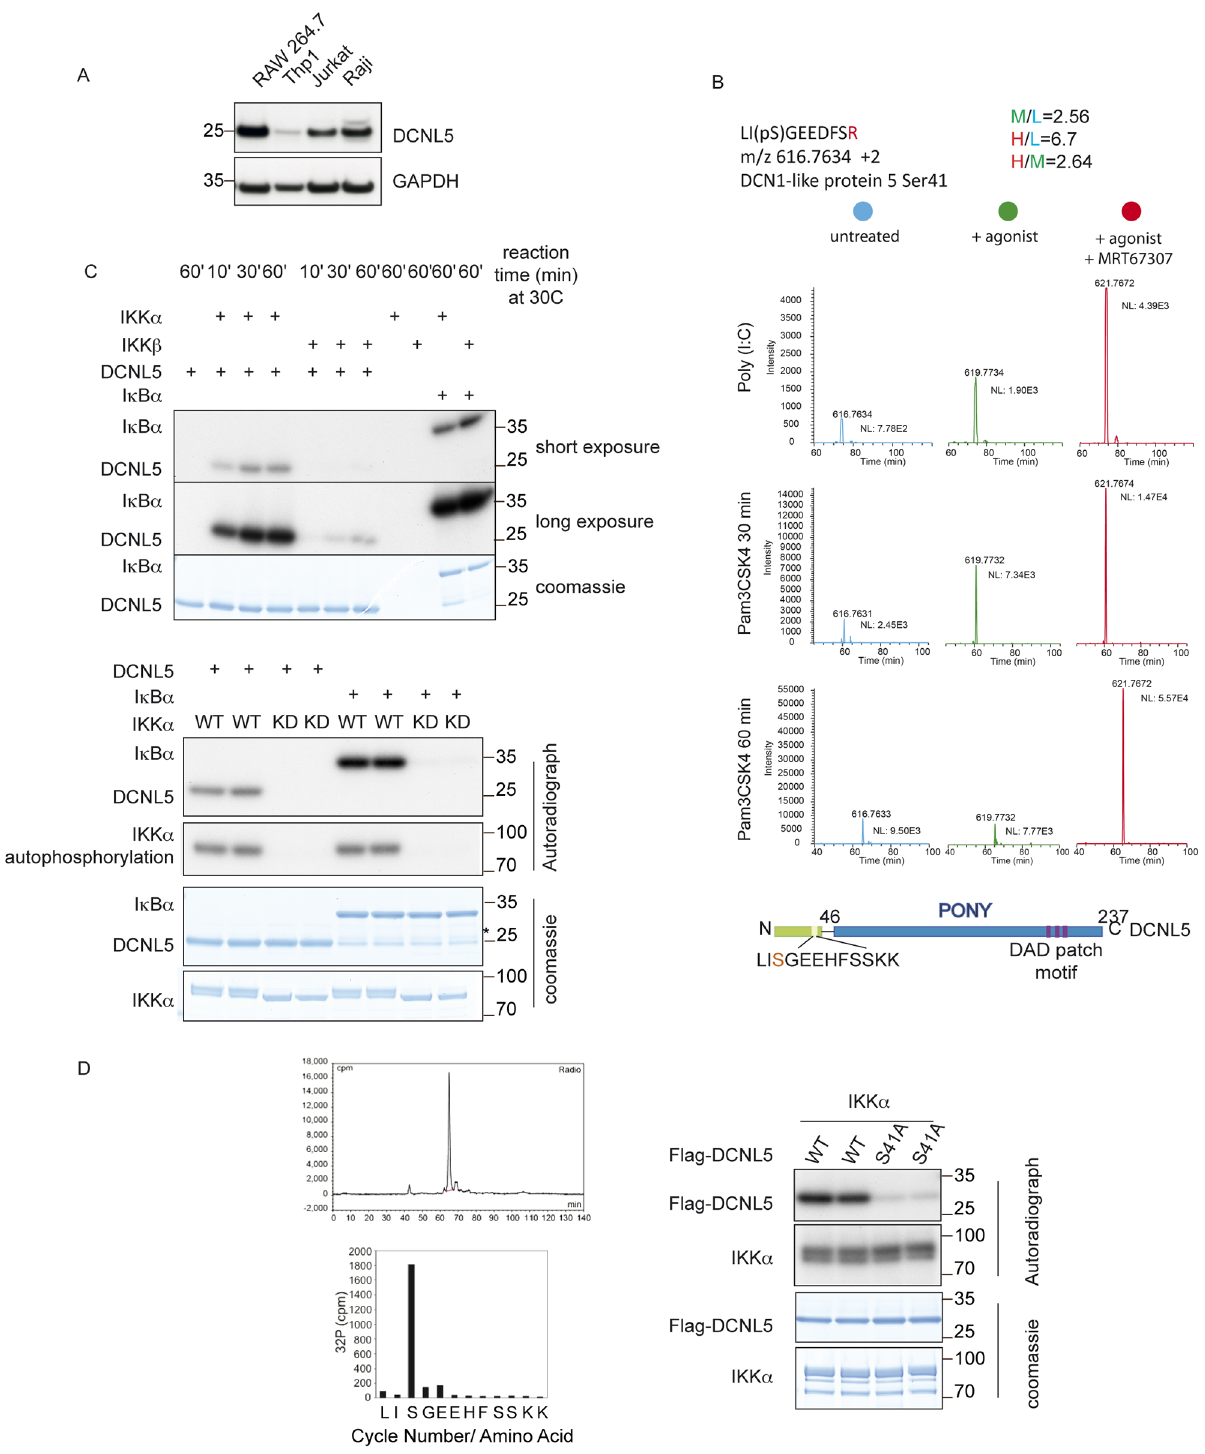
Fig 1. DCNL5 is phosphorylated on Serine 41 by IKK α . (A ) Immunoblot analysis with the indicated antibodies of cell lysates from different cell lines. DCNL5 is strongly expressed in RAW264.7 (immortalized macrophages), Jurkat (immortalized T lymphocytes), and Raji (derived B lymphocytes) cells, while it is present at low levels in Thp1 cells (a monocyte-derived cell line). (B ) Upper panel: Mass spectrum showing phosphopeptide precursor ions corresponding to DCNL5 (amino acids 39–48), which is phosphorylated at Ser41 in RAW264.7 macrophages treated with Poly (I:C) or Pam3CSK4, pre-treatment with MRT67307 (1 μM) for 1 hour enhance the phosphorylation. The results for unstimulated RAW264.7 macrophages are presented in